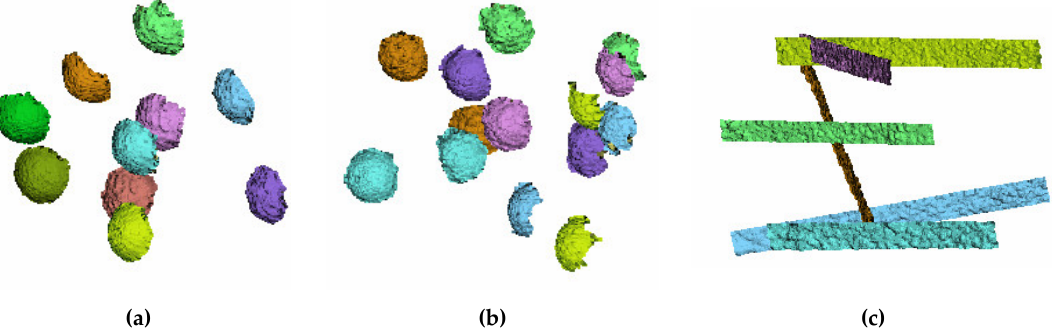
Figure 10. The artefacts proposed to measure the quality parameters inspired by the VDI/VDE standard: ( a ) single sphere having a diameter of 143.15 mm; ( b ) ball-bar composed of two spheres fixed at 391.58 mm from one another; and ( c ) iron bar of dimensions 50 × 646 mm 2 .